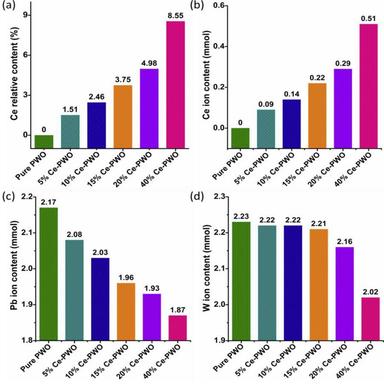
Relative content of Ce (a) and molar quantities of Ce (b), Pb (c) and W (d) in Ce-PWO